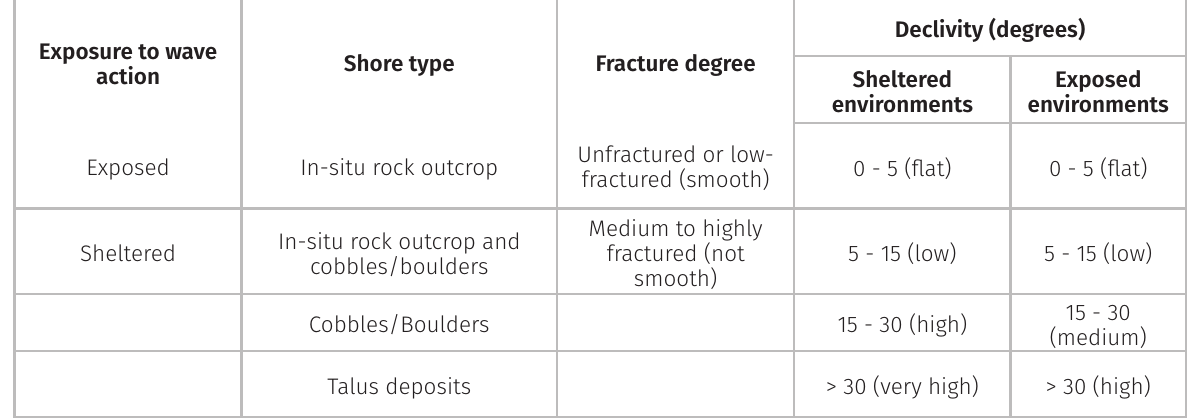
Table IV. Photointerpretative criteria used in the ESI mapping in this study. These criteria followed the guidelines of MMA